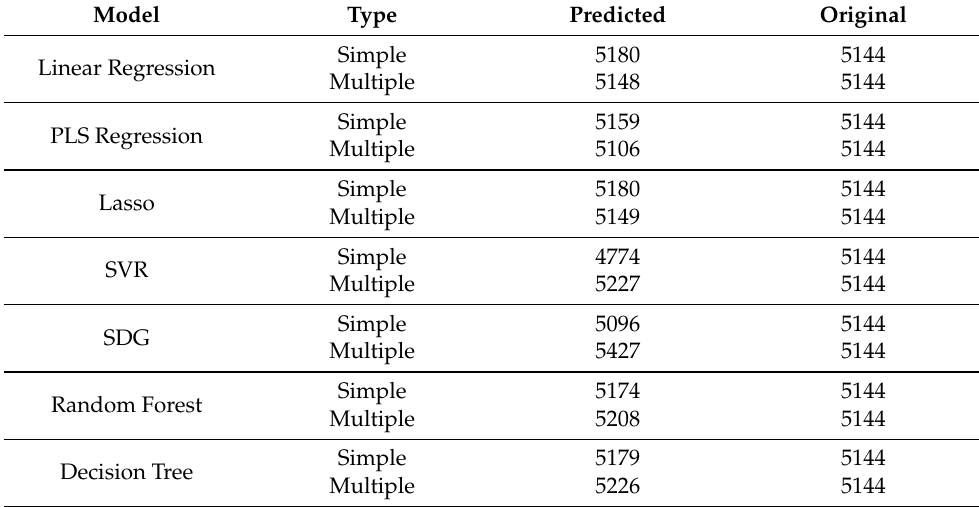
Table 4. Comparison regression models. *Predicted and original values in grains per tree.